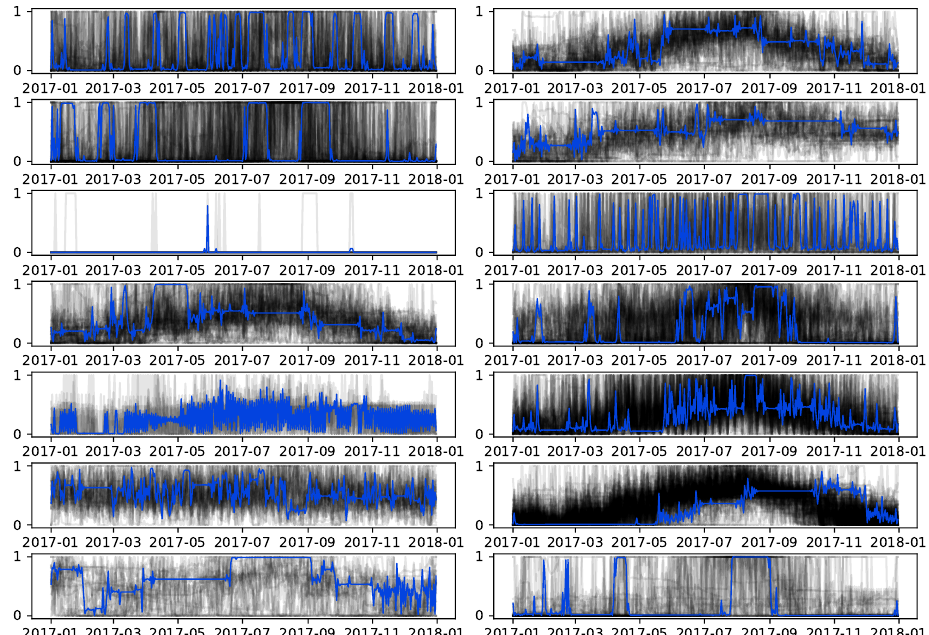
Figure 13. K-means clusters and barycenters for the scaled daily consumption at InfraQuinta, 2017.